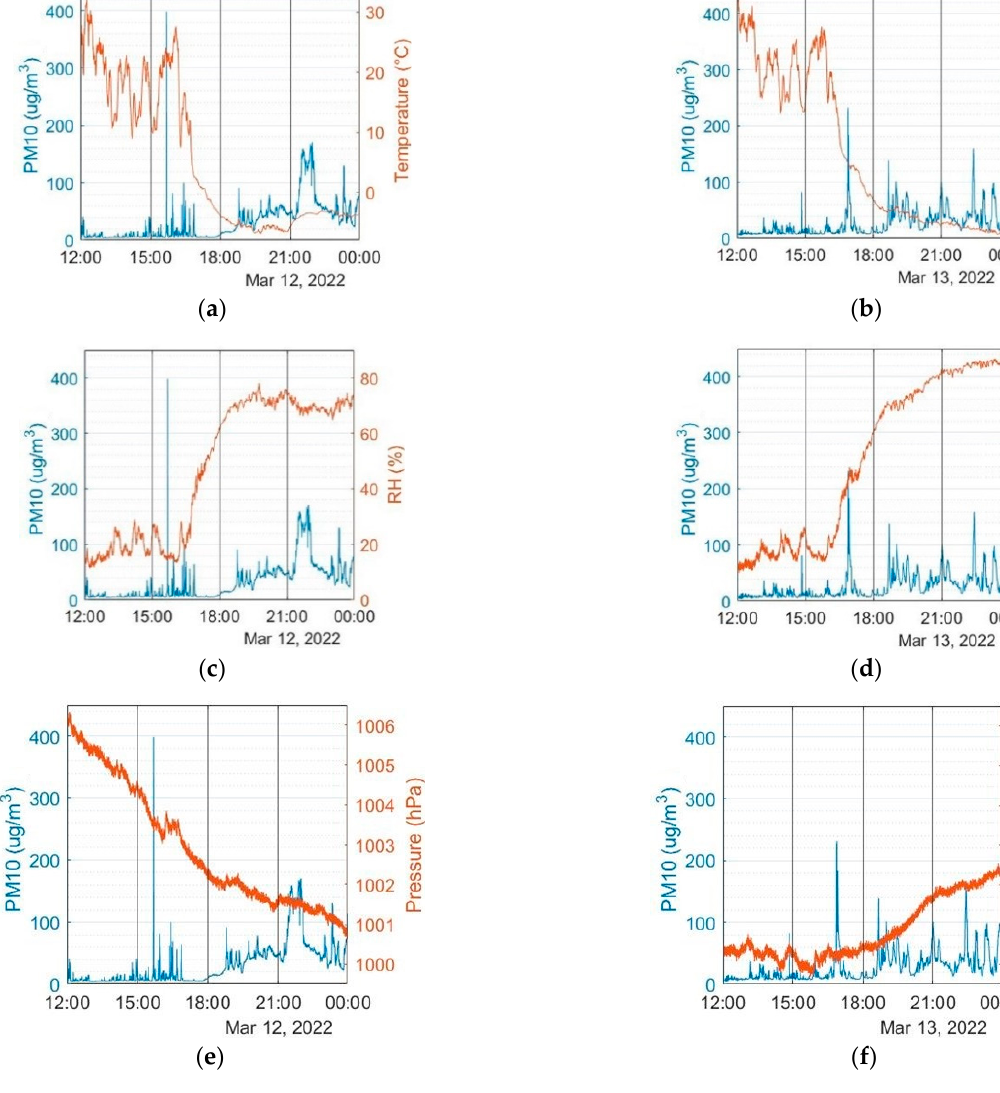
Figure 9. Changes in the measured quantities: PM10 and temperature ( a ) on 12 March 2022, ( b ) 13 March 2022; PM10 and humidity ( c ) on 12 March 2022, ( d ) on 13 March 2022, PM10 and pressure ( e ) on 12 March 2022 and ( f ) 13 March 2022; measured in the garden.